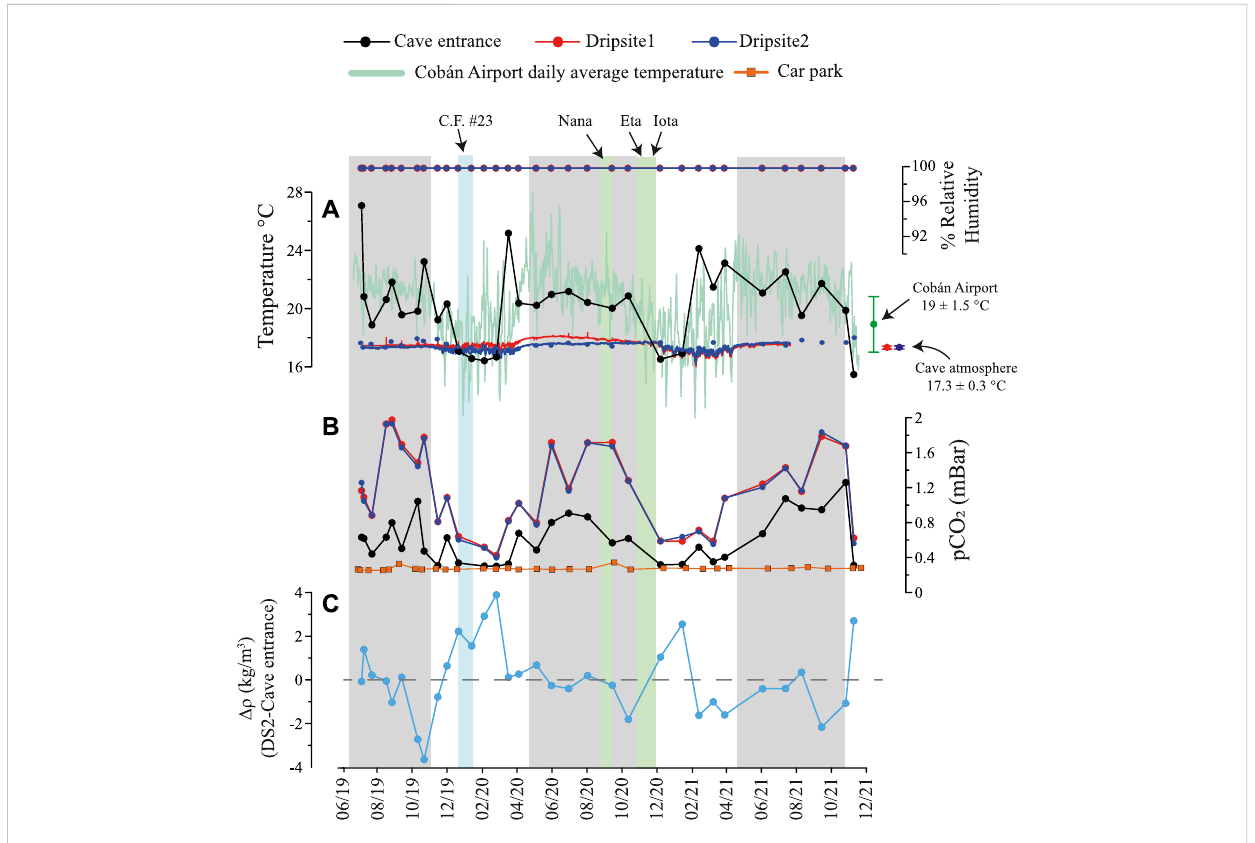
FIGURE 4 Summary ofcave environmentmonitoring from sensors andpoint-measurementsduring eachvisit. Greyband representthemonsoonwetseason, blue stripe: cold-front 23, green stripes: Hurricanes Nota, eta and Iota. (A) Relative humidity, (B) temperature at DS1, DS2, cave entrance and Cobán Airport daily average temperature. Data at the extreme-right represent average +/ − 1 standard deviation. (C) CO 2 partial pressure (pCO 2 — mBar) data measured atdifferentpointsinthecave andthecarpark asabaseline. (D) Difference inair-cave density between DS2 (thedeepest pointof thecave monitored) and the cave